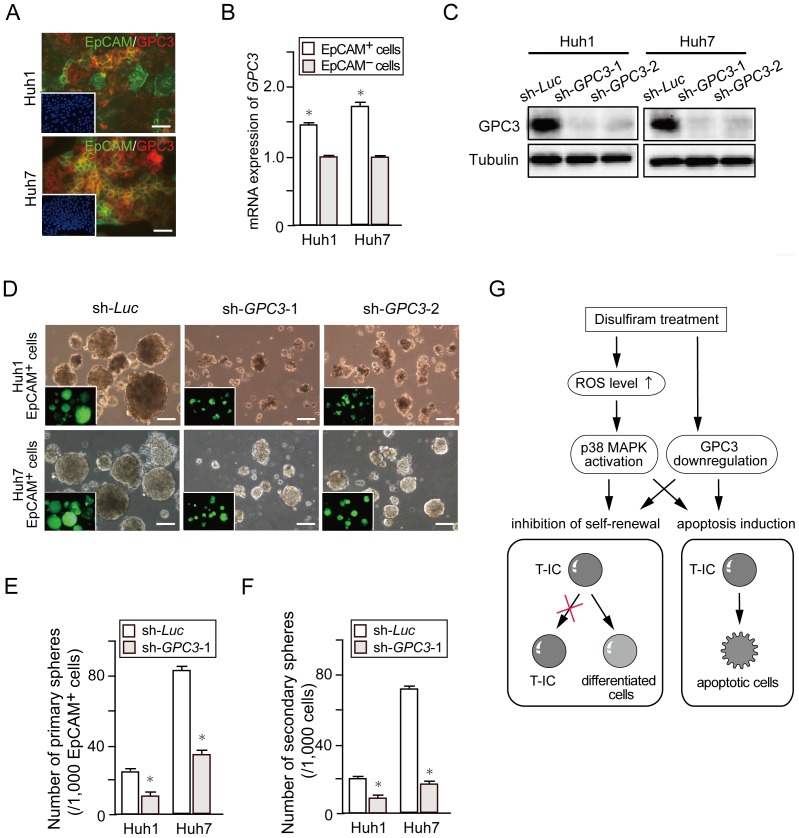
Impact of GPC3 depletion on sorted EpCAM+ HCC cells.(A) Dual immunostaining was performed to detect the expression of EpCAM (green) and GPC3 (red). Nuclear DAPI staining is shown in the insets. Scale bar = 100 μm. (B) Real-time RT-PCR analysis of GPC3 expression in purified EpCAM+ cells. *Statistically significant (p<0.05). (C) Cells transduced with the indicated lentiviruses were subjected to Western blotting using anti-GPC3 and anti-tubulin (loading control) antibodies. (D) Bright–field images of non-adherent spheres on day 14 of culture. Fluorescence images are shown in the insets. Scale bar  = 100 μm. (E) Number of large spheres derived from 1,000 EpCAM+ or EpCAM− cells at day 14 of culture. *Statistically significant (p<0.05). (F) Number of secondary spheres 14 days after replating. *Statistically significant (p<0.05). (G) A proposed model for the effect of DSF in targeting tumor-initiating HCC cells.